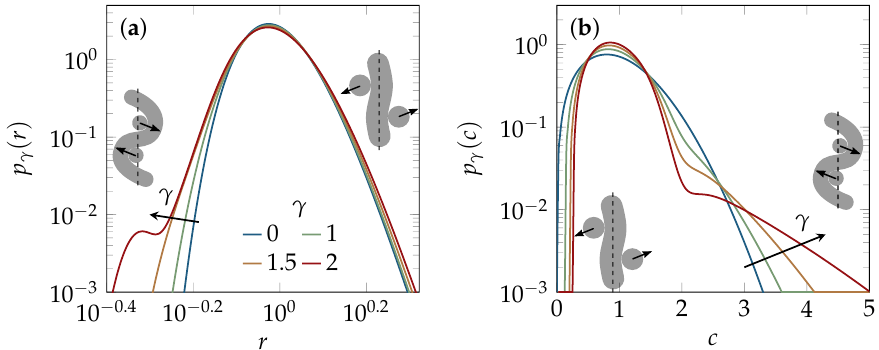
Figure 2. How shear affects packing structure in the unit-cell model [21]. In contrast to the most probable tube conformations, rare hairpin configurations are buckled and pulled tighter by increasing shear (as sketched in the insets). They are responsible for the tails emerging upon increasing strain γ in the concentration-independent master curves of the reduced probability distribution functions ( γ ) P [ r ( γ )] for the tube width and ( b ) p γ ( c ) ( γ ) P γ [ c ( γ )] for the tube ( a ) p γ ( r ) ≡ R R ≡ C C